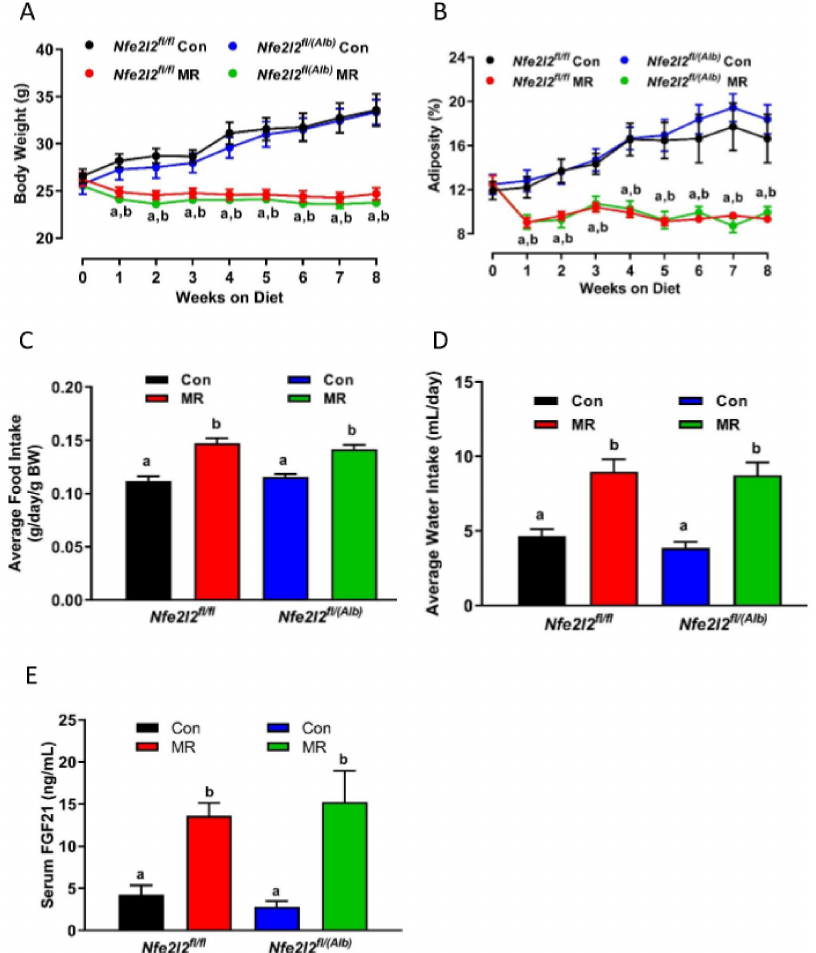
Figure 2. Assessment of impact of dietary MR on body weight ( A ), adiposity ( B ), average food intake ( C ), average water intake ( D ), and serum FGF21 ( E ) in Nfe2l2 fl/fl (WT) and Nfe2l2 fl/(Alb) ( NRF2 KO) mice fed Con or MR diets for 8 weeks beginning at 8 weeks of age. Body weight, adiposity, food intake, and water intake were measured weekly for the entire study. The means of food intake and water intake were averaged over the entire study, while serum collected at the end of the study was used for measurement of FGF21. The change in body weight and adiposity over time were analyzed using a repeated measures two-way ANOVA as described in the Materials and Methods, and the Con means annotated with an ‘a’ differ between Nfe2l2 fl/fl mice fed Con or MR diets, and Con means annotated with a ‘b’ differ between Nfe2l2 fl/(Alb) mice fed Con or MR diets. Food intake, water intake, and serum FG21 were analyzed by two-way ANOVA and means annotated with different letters differ at p < 0.05. Data in each figure panel are presented as the mean ± SEM, n =